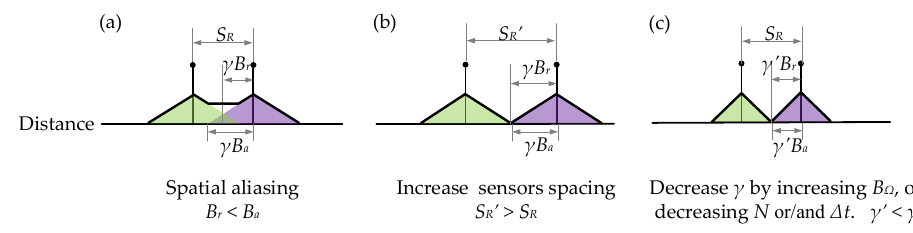
Figure 7. Relationship between the spatial resolution ( S R ) and reception bandwidth ( B r ) . ( a ) Spatial aliasing when S R < 2 γ B a . ( b ) Increase S R or ( c ) decrease γ to avoid spatial aliasing.